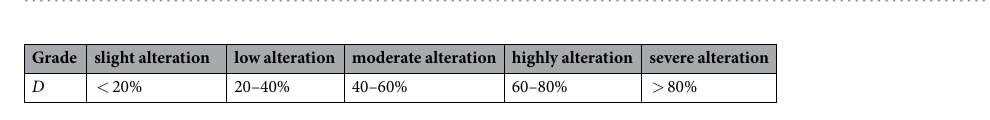
Table 5. Indicators of hydrological alteration (32 IHAs).